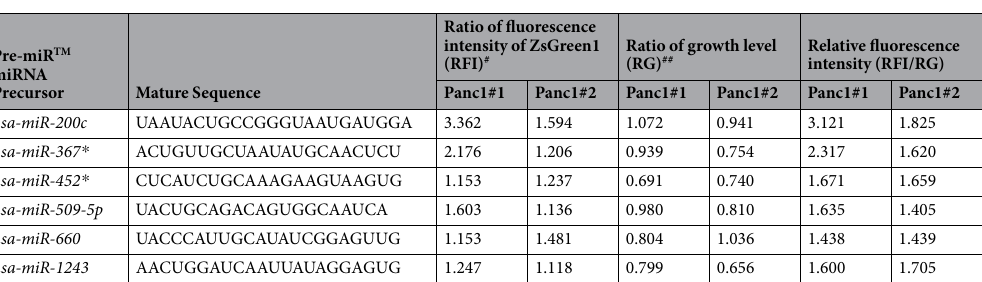
Table 1. Summary of six miRNAs selected as candidates for EMT-suppressive miRNAs in functional-based screening using stable Panc1 clones transfected with a reporter construct containing a promoter sequence of CDH1/E-cadherin in the upstream region of the ZsGreen1 reporter gene and Pre-miRTM miRNA Precursor Library - Human V15 (Ambion). # RFI in cells 72 hours after transfection with each miRNA was normalized to that in miR-NC transfectants. ## RG of viable cells assessed by cristal biolet staining 72 hours after transfection with miRNAs. This assay was employed to normalize the number of viable cells relative to the control